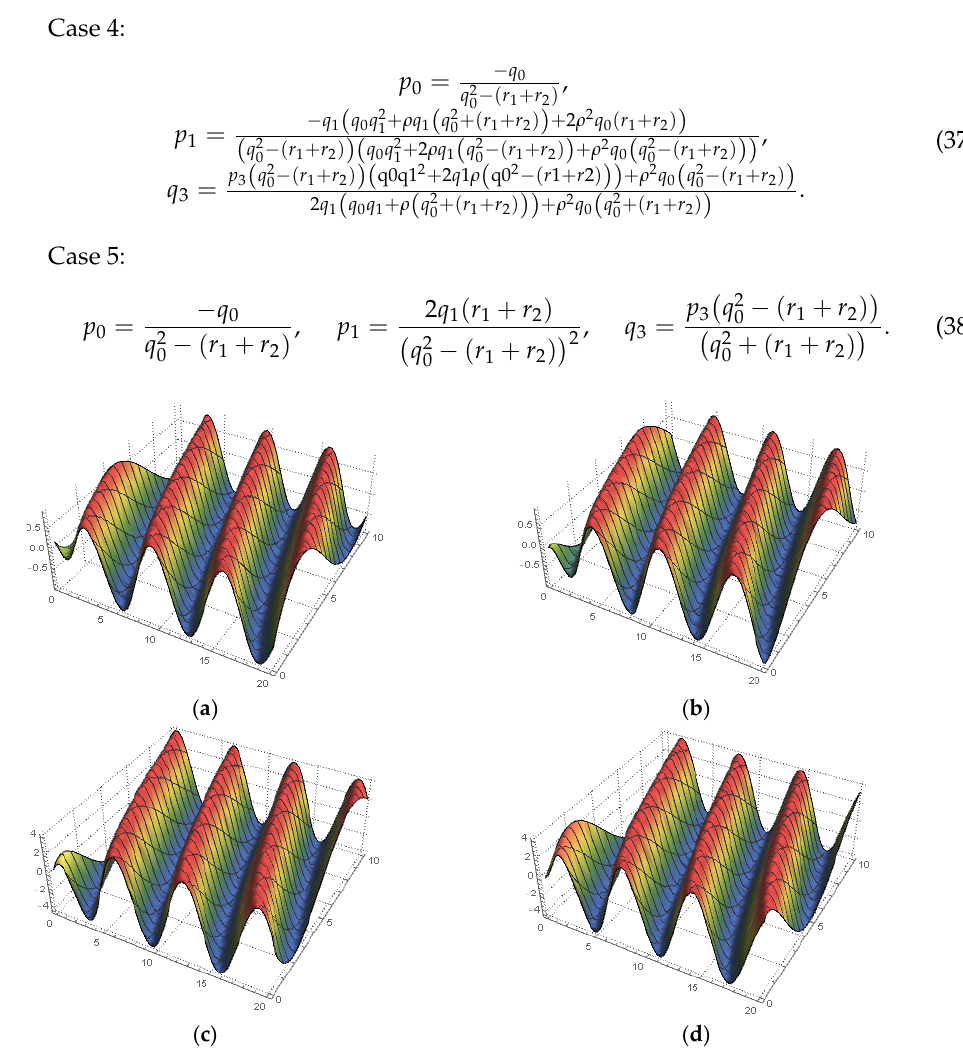
and with the parameters and for the fractional order : 𝐹𝐹 2 ( 𝑥𝑥 , 𝑑𝑑 ) 𝐺𝐺 2 ( 𝑥𝑥 , 𝑑𝑑 ) 𝜌𝜌 = 𝜏𝜏 = 1 𝛼𝛼 = 0.85